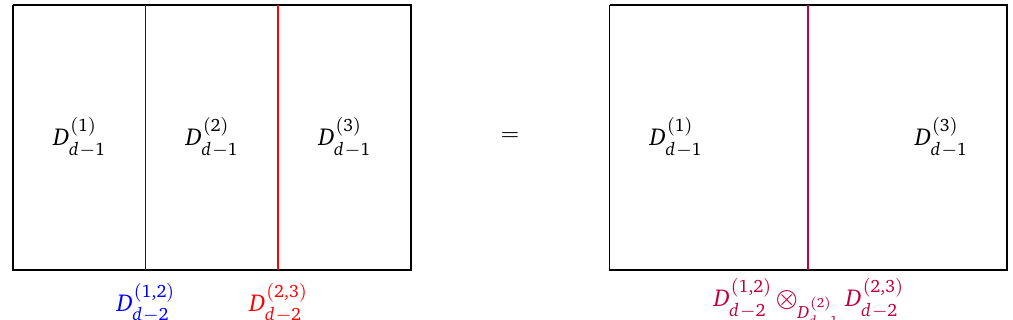
and D p 2,3 q now is represented as a monoidal d ´ 2 d ´ 2